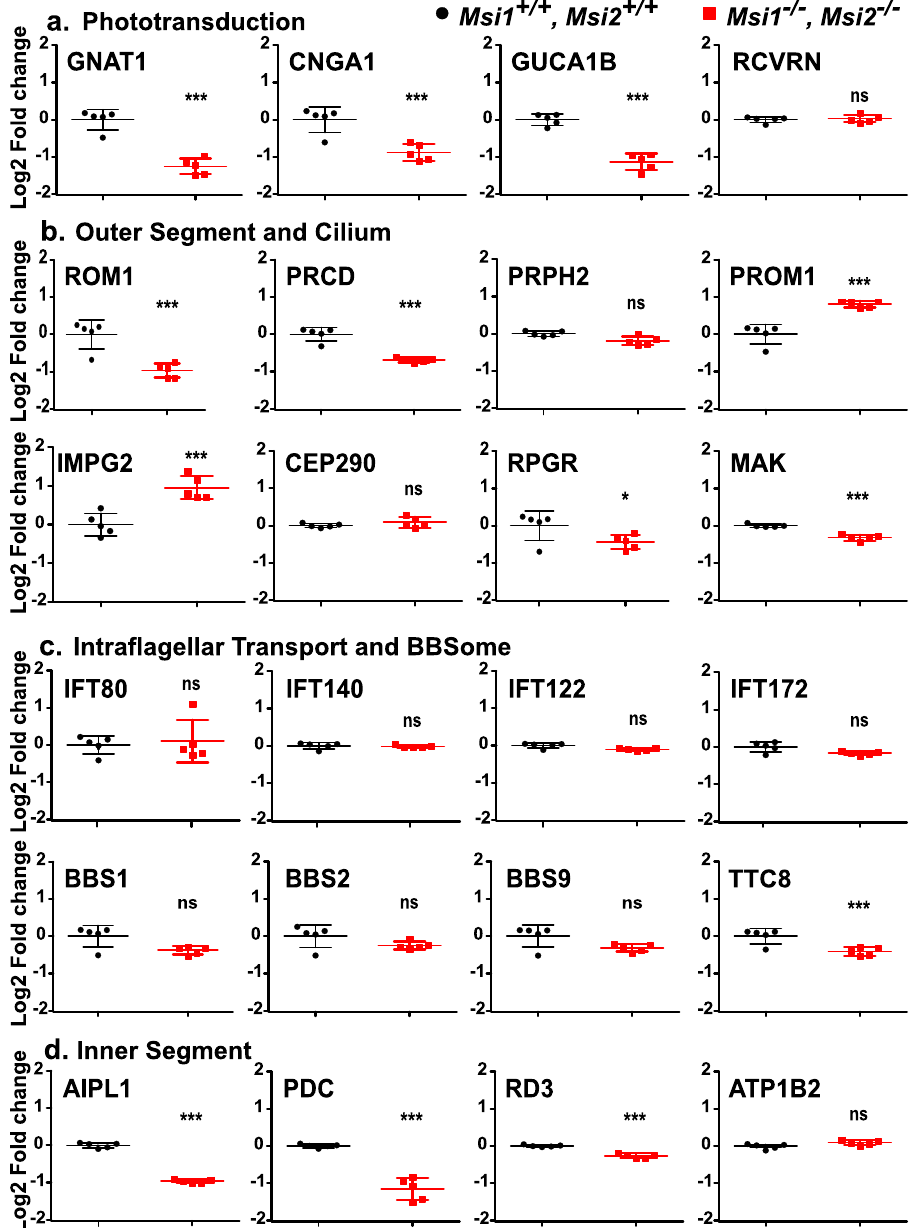
Fig. 7 Expression of proteins critical for photoreceptor function after induced knockout of Msi1 and Msi2 in photoreceptor cells. Boxplots representing the log2 of the fold change in protein expression relative to the median of the control. Retinal samples were collected 21 days after inducing the knockout at postnatal day 30. Protein levels were determined using isobaric labeling and mass-spectroscopy. Boxplots represent a selected set of proteins that are components of the phototransduction pathway ( a ), outer segment primary cilium structure ( b ), intra fl agellar transport complex and BBSome ( c ), and the inner segment ( d ). The data is represented as mean ± SEM of fi ve replicates. Signi fi cance level is indicated as: *adjusted p -value < 0.05, **adjusted p - value < 0.01, ***adjusted p -value < 0.001. Supplementary Data 18 contains the source data underlying the